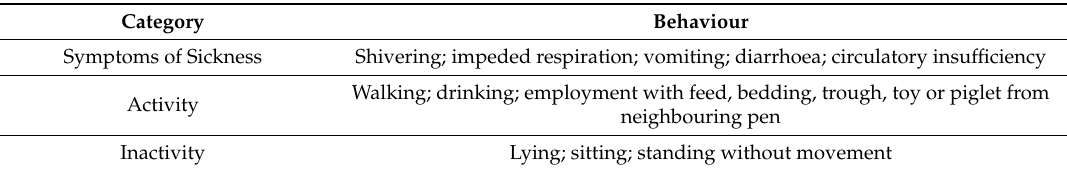
Table 4. Categories and their related behaviours used for the assessment of sickness severity and